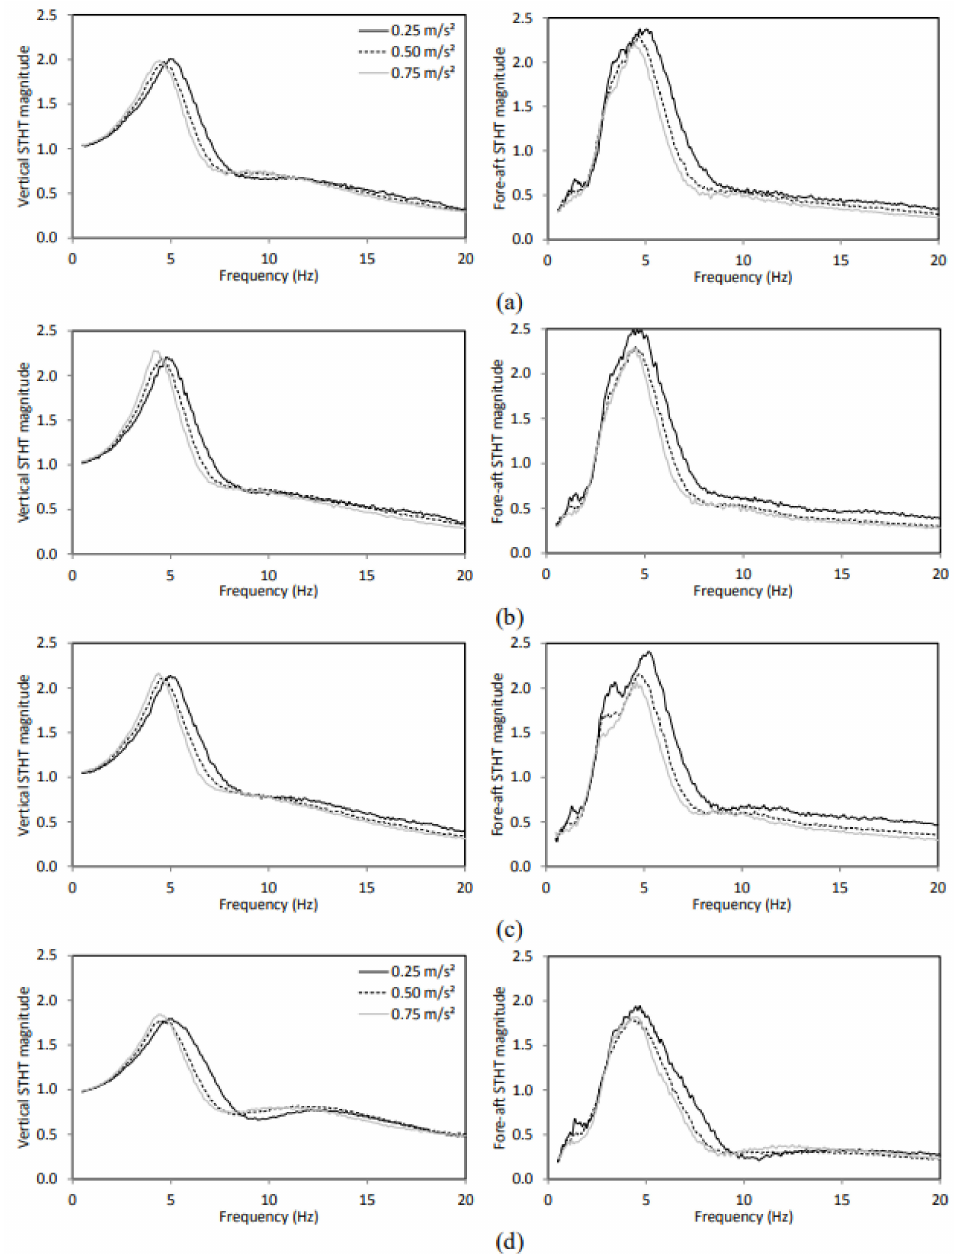
Figure 9. Influence of excitation magnitude on the mean STHT magnitude responses of 58 participants sitting without back support: ( a ) seat A; ( b ) seat B; ( c ) seat C; and ( d ) rigid